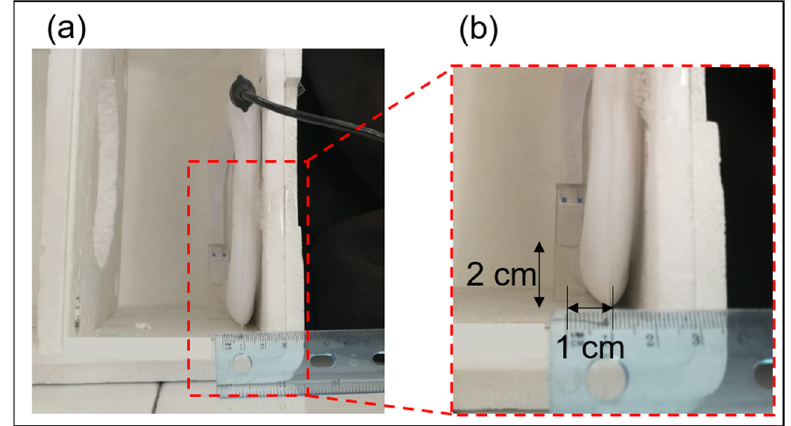
Figure 1. ( a ) Complete experimental setup in place for PEMFs exposures. ( b ) Zoom of the exposure setup to show the distance between coil and cuvette centers. setup to show the distance between coil and cuvette